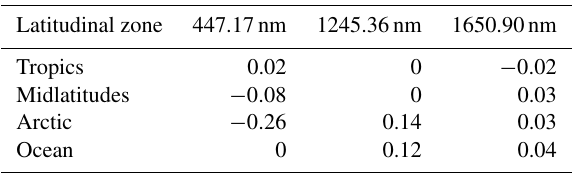
Table 4. Difference in mean values of the TOA reflectance thresh- olds in each zone from the overall thresholds. These differences are calculated by using the mean value in each band for the “All” cate- gory and subtracting the mean of each zone individually from this value.